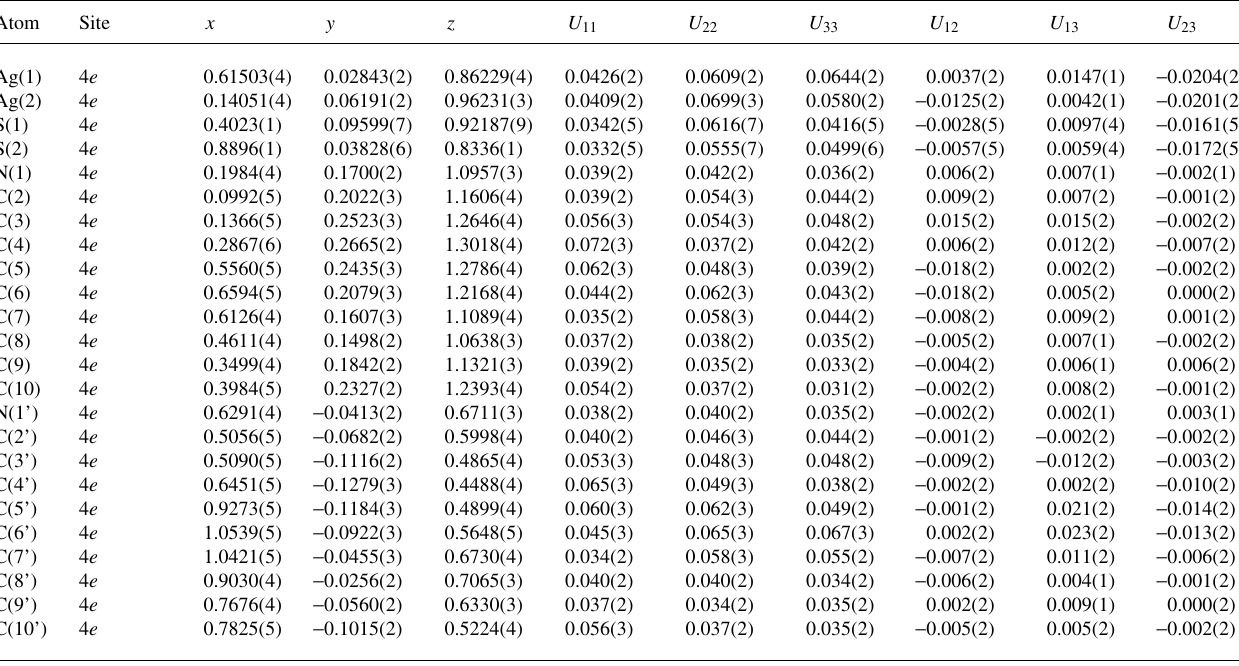
Table 3. Atomic coordinates and displacement parameters (in Å 2 ) .